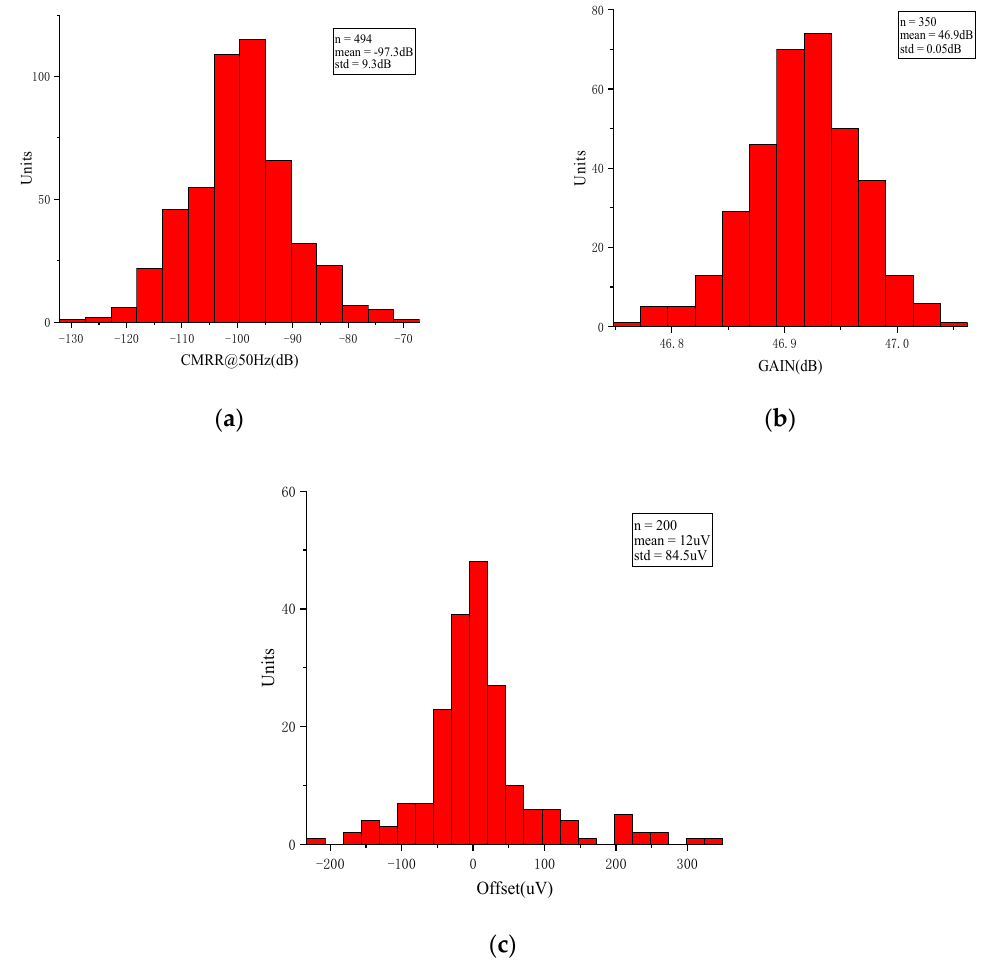
Figure 14. The Monte Carlo analysis of: ( a ) CMRR, ( b ) Closed-loop gain, ( c ) Input offset.